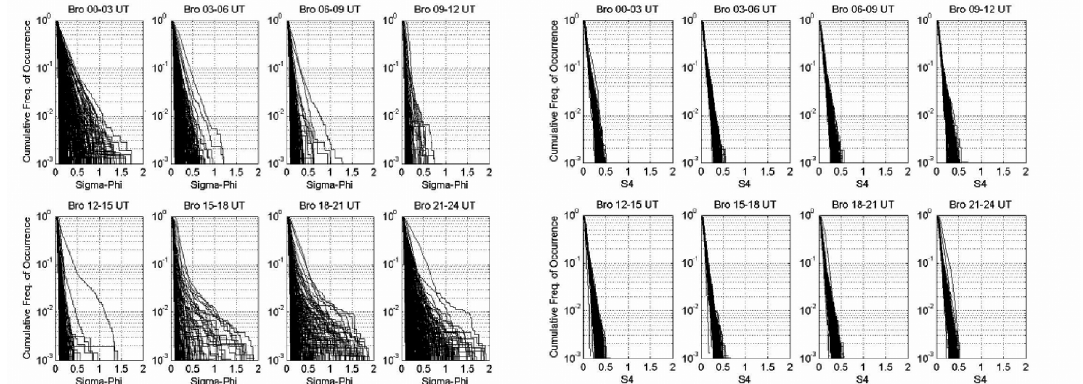
Fig. 16. Cumulative frequency of occurrence of phase and amplitude scintillation values for station Bronnoy- sund (~65 o N) for year